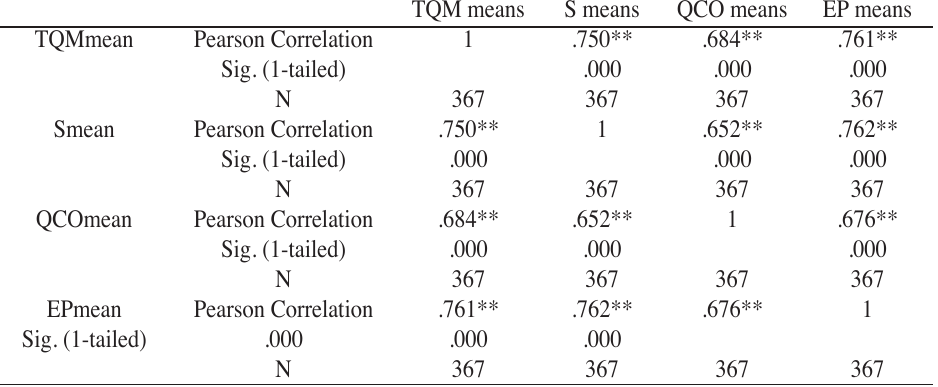
TQM means S means QCO means EP means